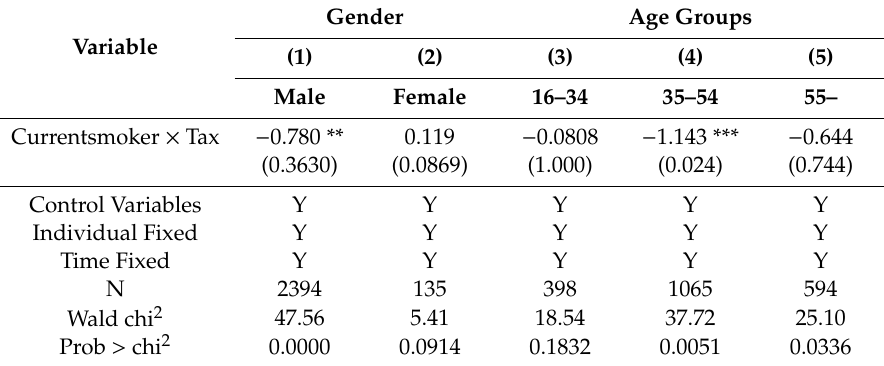
Table 5. Regular drinking behavior responses to the cigarette tax by gender and age